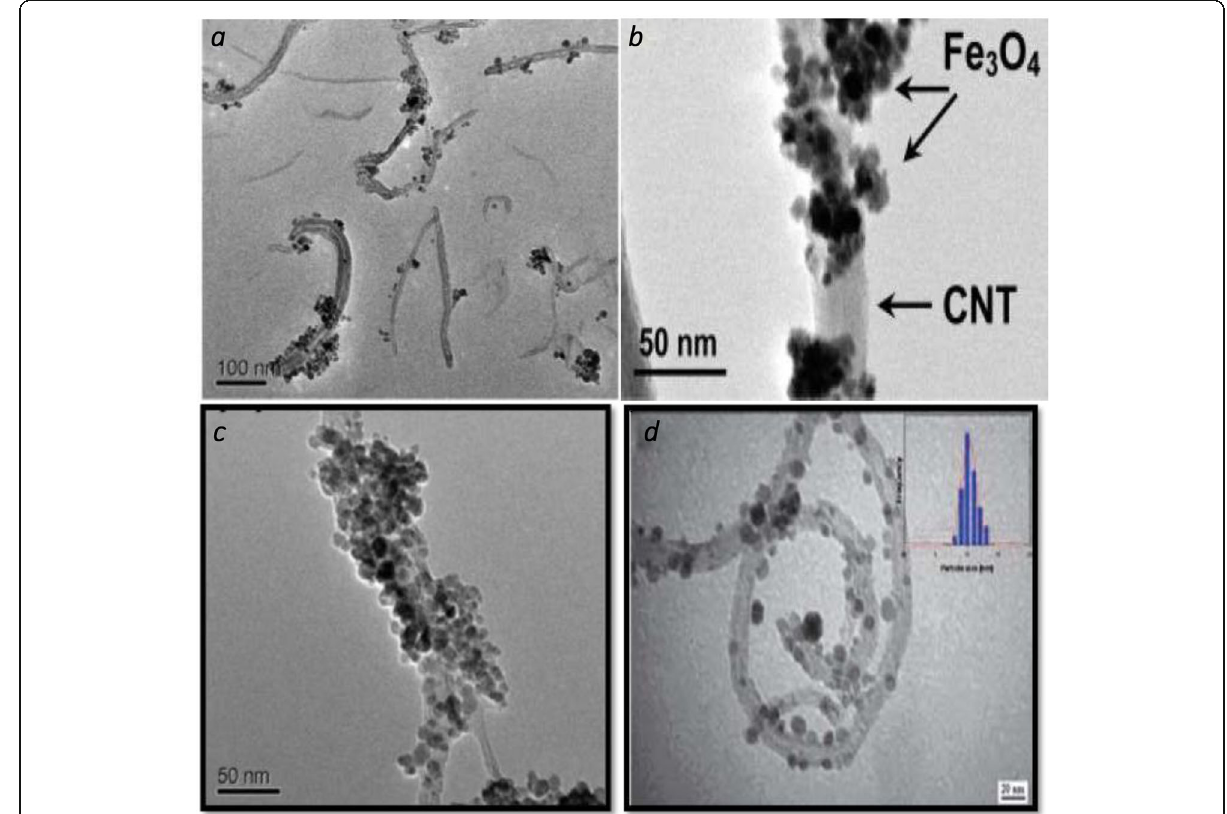
Fig. 2 TEM images of the ( a ), ( b ), ( c ) magnetic nanotube Fe 3 O 4 / MWCNTs at two magnification, and ( d ) TEM images of maghemite γ – -Fe 2 O